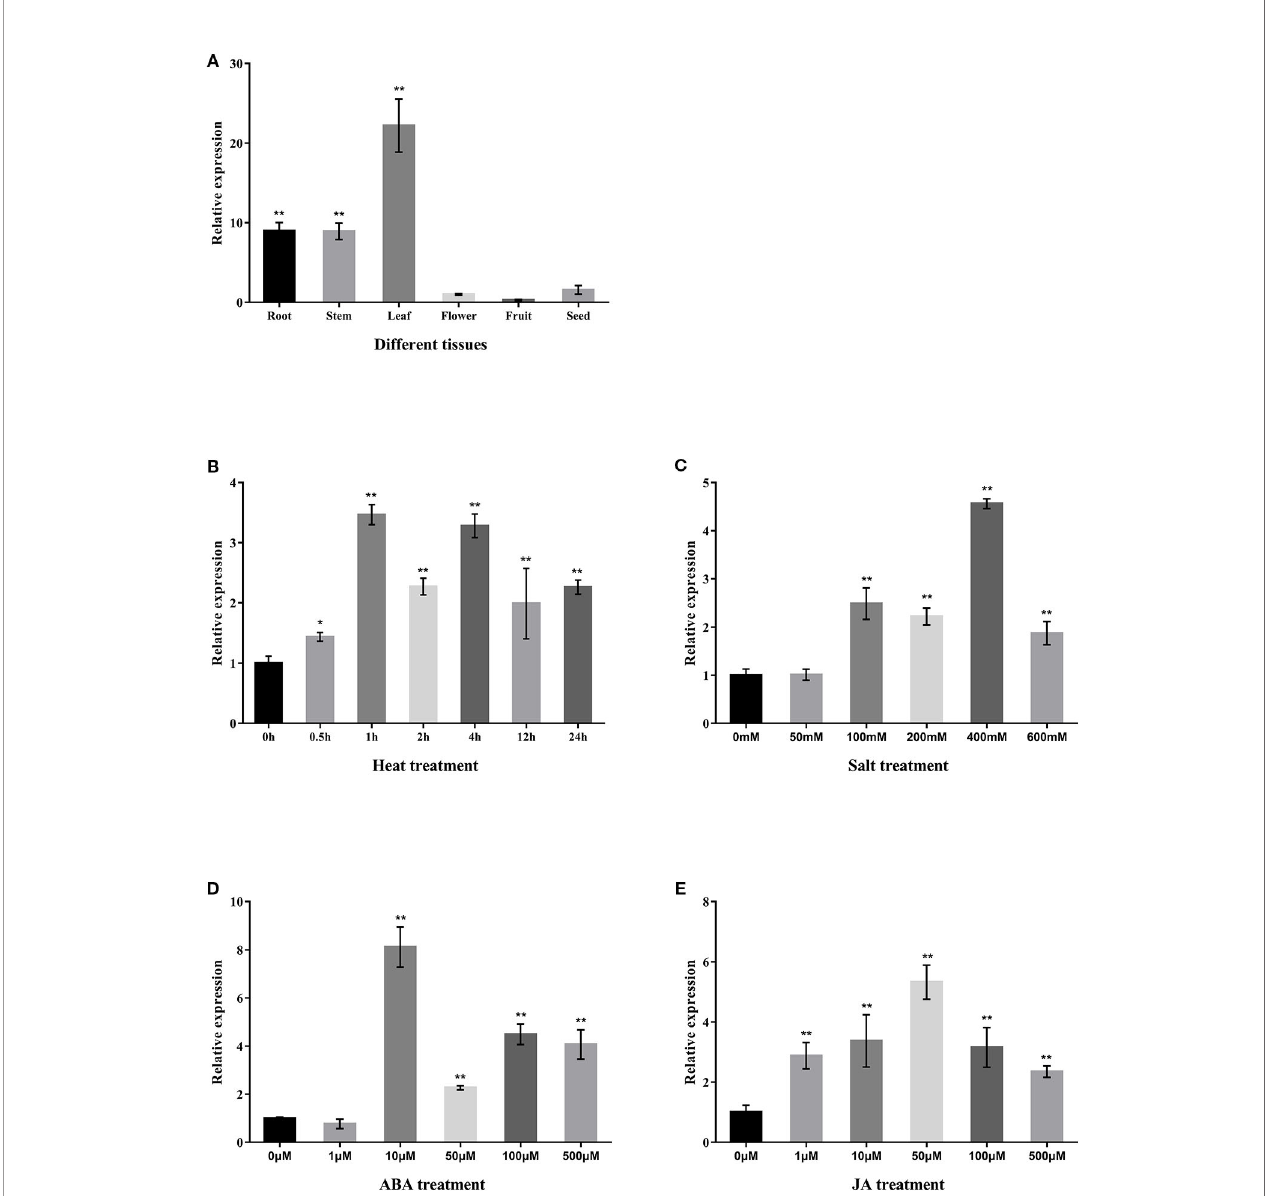
FIGURE 5 | CabZIP25 expression patterns (A) in different pepper tissues, under (B) heat stress induction at 45°C, (C) NaCl root-immersing, (D) ABA spraying, and (E) JA spraying. The relative expression levels of CabZIP25 are normalized to that of CaUBI3 . Error bars represent SDs for three replicates, and each replicate contains six pepper seedlings. Data are shown as means ± SD. The asterisks on the bars indicate signi fi cant differences from the CabZIP25 expression in fl ower (A) or control treatments (B – E) . * P < 0.05, ** P < 0.01 by Student's t